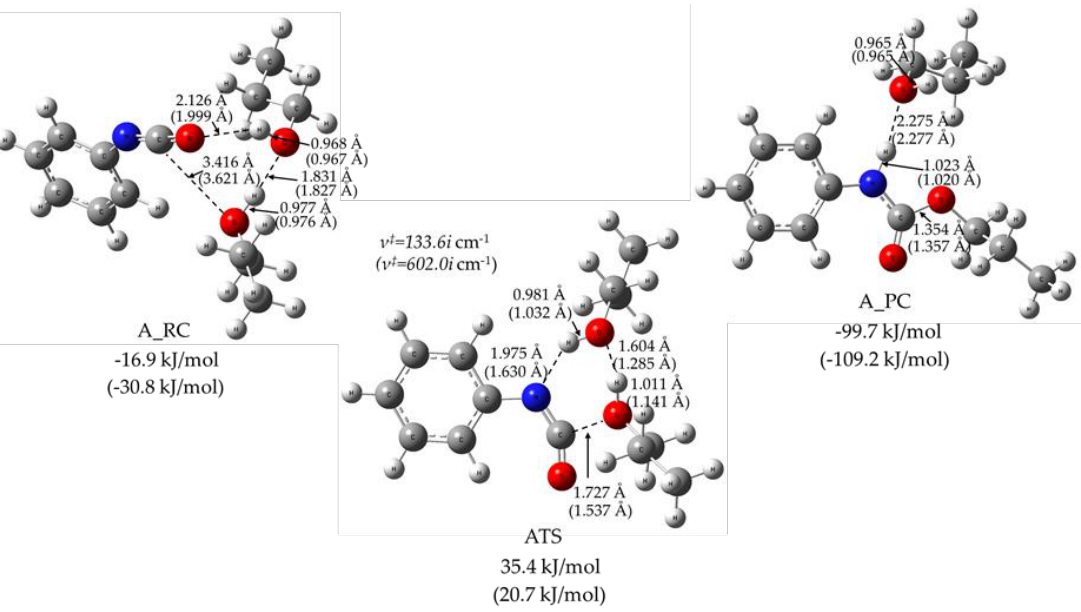
Figure 4. Reactive complex (RC), transition state structure (TS) and product complex (PC) structures (obtained at a B3LYP/6-31G(2df,p) level of theory from the G4MP2 calculation) for the alcohol excess reaction mechanism of urethane bond formation in solvent 1-PrOH or THF (in parenthesis). The relative zero-point corrected energies are also presented in kJ/mol.